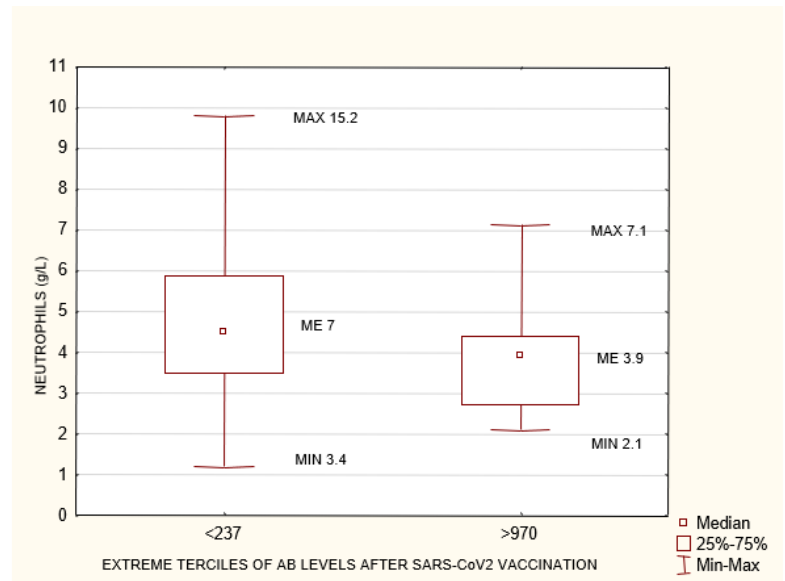
Figure 9. The group of patients with no history of SARS-CoV-2 infection prior to vaccination. Statistically significant differences in neutrophiles concentration (g/L) between the extreme terciles of post-SARS-CoV-2 vaccination antibody levels <237 AU/mL and >970 AU/mL. Mann–Whitney U test. p = 0.03. AB: antibody.